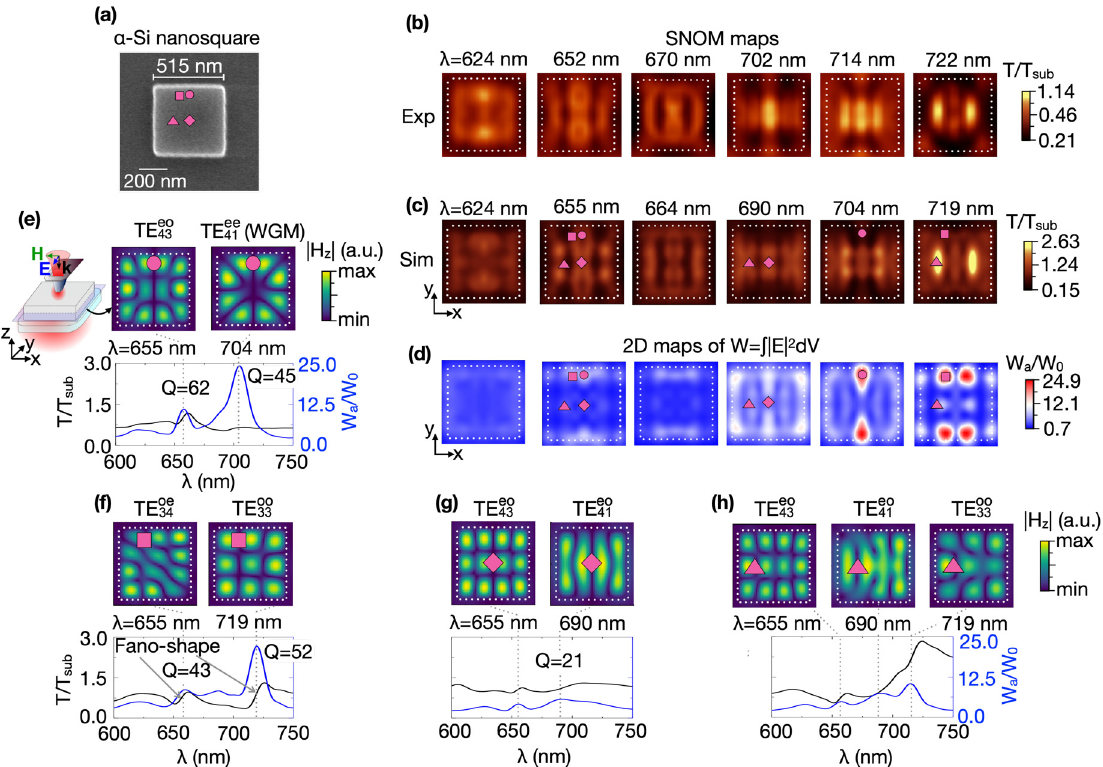
Figure 2: (a) SEM image of the 𝛼 -Si nanosquare. The side length is 515 nm, and the thickness is 96 nm. Experimental (b) and simulated (c) SNOM maps of the 𝛼 -Si nanosquare at different wavelengths. The polarization of the light incident on the SNOM probe (blue arrow) is /W at the same wavelengths of the SNOM maps in (c). The directed along the y − axis. (d) Simulated 2D maps of electric field localization W 0 a circle ( x = 0 nm, y = 220 nm), square ( x = 80 nm, y = 200 nm), diamond ( x = 0 nm, y = 0 nm), and triangle ( x = 120 nm, y = 0 nm) symbols on 2D maps in (a), (c), and (d) depict the SNOM probe positions corresponding to maxima of electric field localization. (e–h) The simulated (black curves) and electric field localization W /W (blue curves) spectra recorded at the fixed positions of the SNOM transmittance T / T sub 0 a | distributions of /W (d) maps. The top rows in (e–h) show the simulated | H SNOM probe marked as purple symbols on SNOM (c) and W 0 a z | field was taken at central xy − cross-sections of the nanosquare as shown in the sketch in panel (e). Dotted optical modes. The | H TE ij z mn white lines indicate the boundary of the